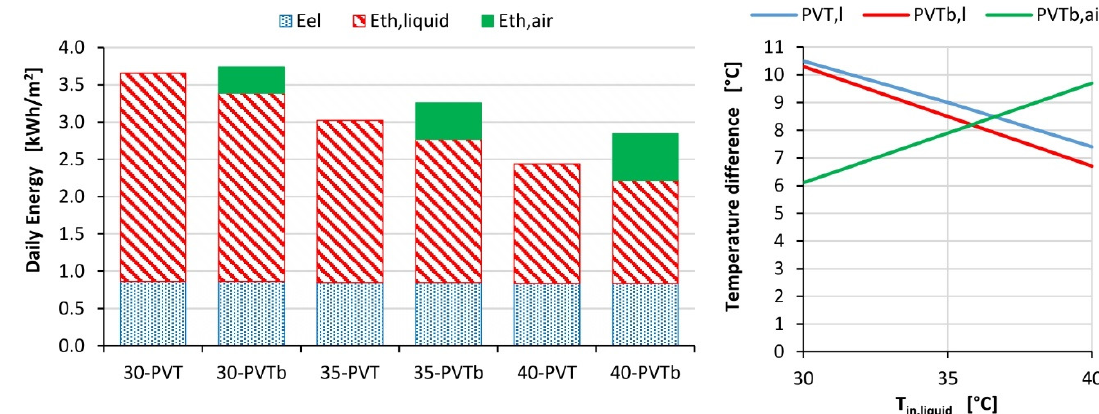
Figure 11. Daily energy yields for conventional and bi-fluid PVT (left), and thermal jump (right) as a function of the inlet water temperatures.